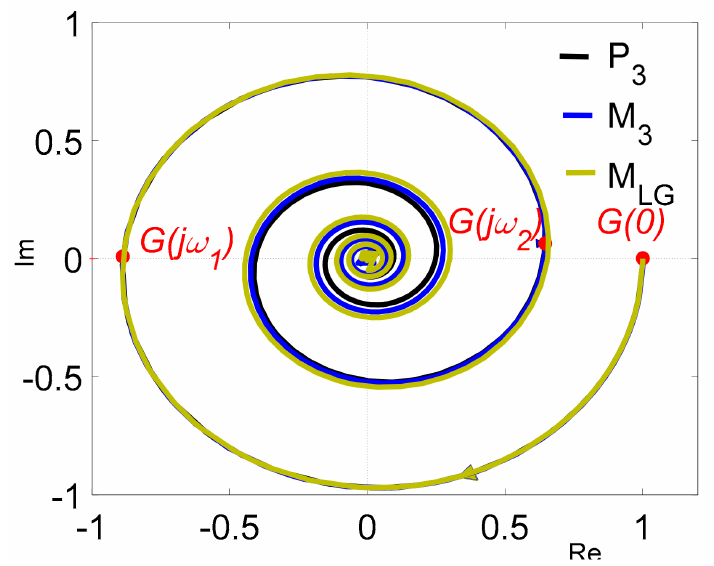
Figure 15. The Nyquist frequency plots of transfer functions P 3 ( s ), M 3 ( s ), and M LG ( s ). The unit step responses of process P 3 ( s ), model M 3 ( s ), and model M LG ( s ) are shown in Figure 16.